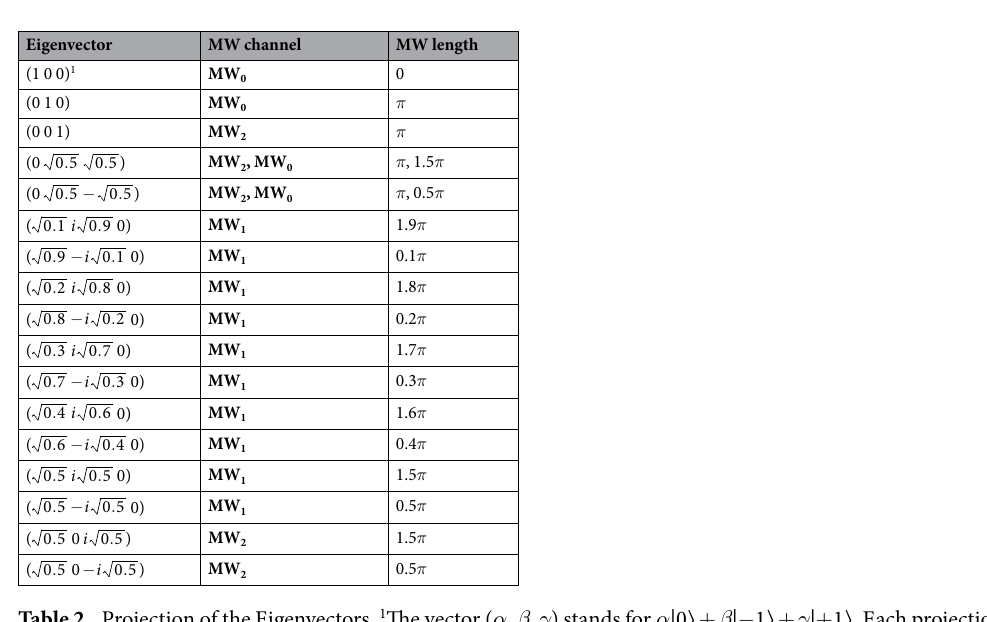
Table 2. Projection of the Eigenvectors. 1 The vector ( α , β , γ ) stands for α |0 〉 + β | − 1 〉 + γ | + 1 〉 . Each projection process is carried out by MW pulses from left to right with MW lengths listed